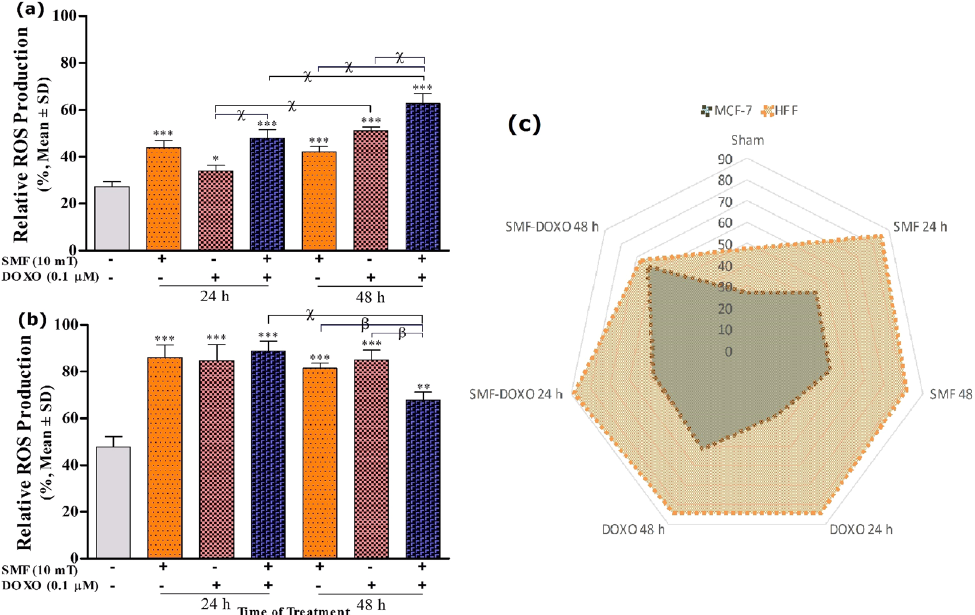
Figure 5. The cellular ROS results of ( a ) MCF-7, ( b ) HFF cells and ( c ) both comparison exposed with 10 mT SMF and incubated with 0.1 μ M DOXO for two exposure times (24 and 48 h). The ROS production was measured by flow-cytometry fluorescent probe DCFDA, and results are expressed as the percentage of ROS production (fluorescent intensity per 10 4 cells). Data are shown as mean ± SD (n = 3). * P < 0.05; ** P < 0.01; *** P < 0.001 . Significant difference relative to unexposed cells (sham; was measured at 48 h), and letters ( β , P < 0.01; X, P < 0.001) . Significant differences between treated cells (2 × 2 × 2 factorial ANOVA flowed by post-hoc Newman–Keuls multiple comparison tests).